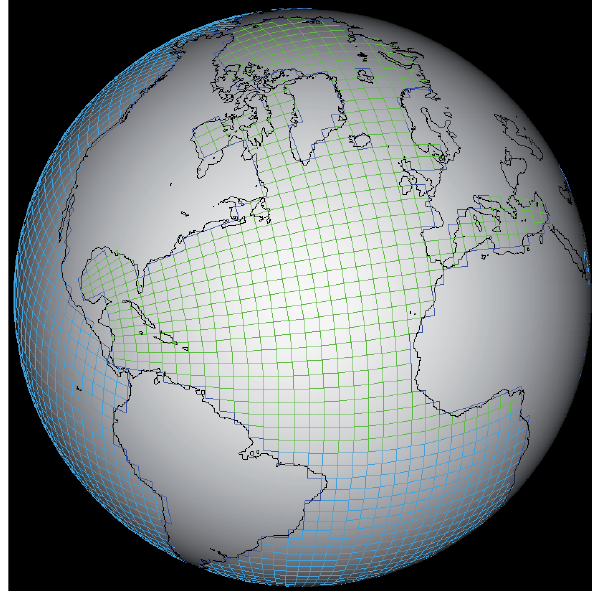
Fig. 4. The horizontal grid of CLIO at a resolution of 3° by 3°. The view is centred on the Atlantic. The two spherical subgrids in two different colors are connected in the Atlantic at the "geographical equator".